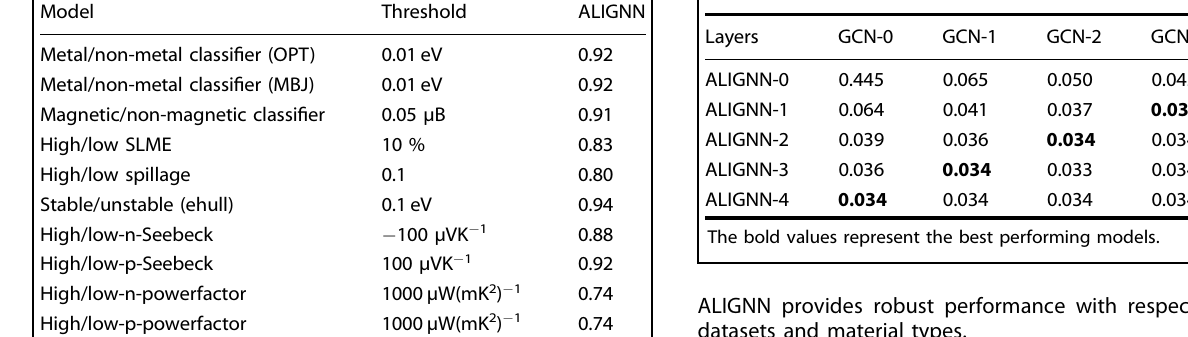
Table 6. Effect of changing ALIGNN and GCN layers on